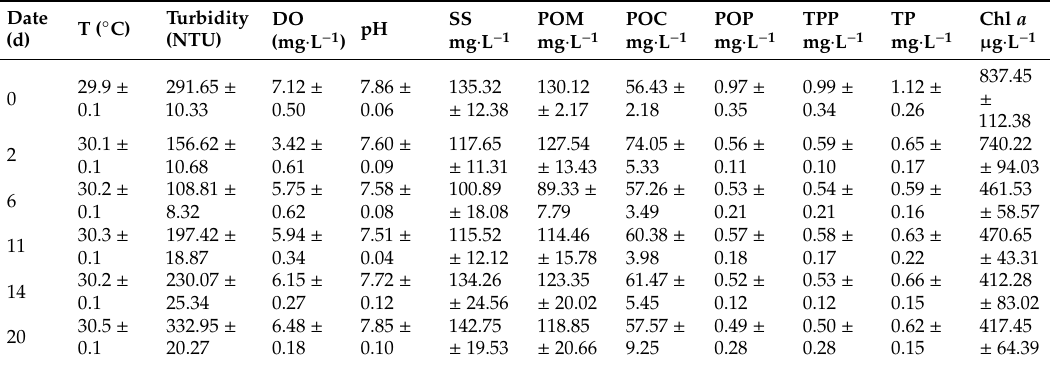
Table 1. Physical and chemical indicators of water samples during PPOM degradation